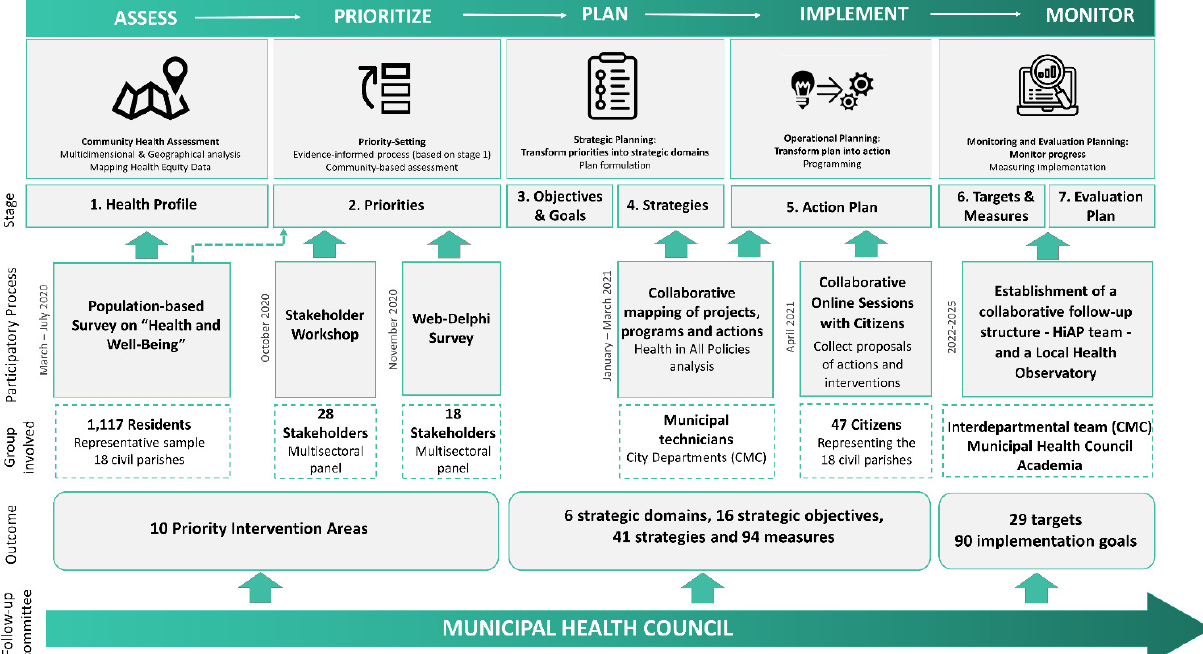
Figure 2. The planning cycle and applied participatory processes in the MHS of